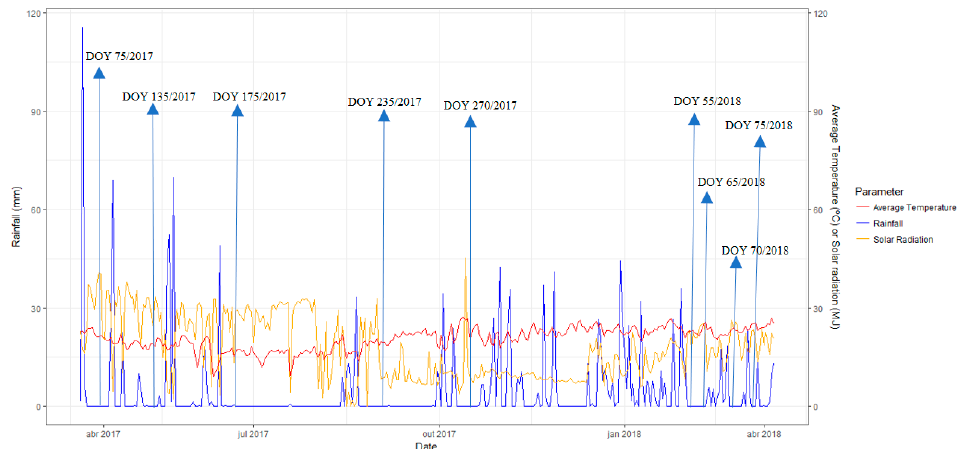
Figure 4. Rainfall ( P ), average temperature ( T A ), and solar radiation ( R G ) at a daily scale between 16 March 2017 and 2 April 2018 in watersheds located in the municipality of Águas de Santa Bárbara, the central-western part of São Paulo State, Brazil. The temporal location of the DOYs of the present research is indicated by arrows (DOY = day of year).